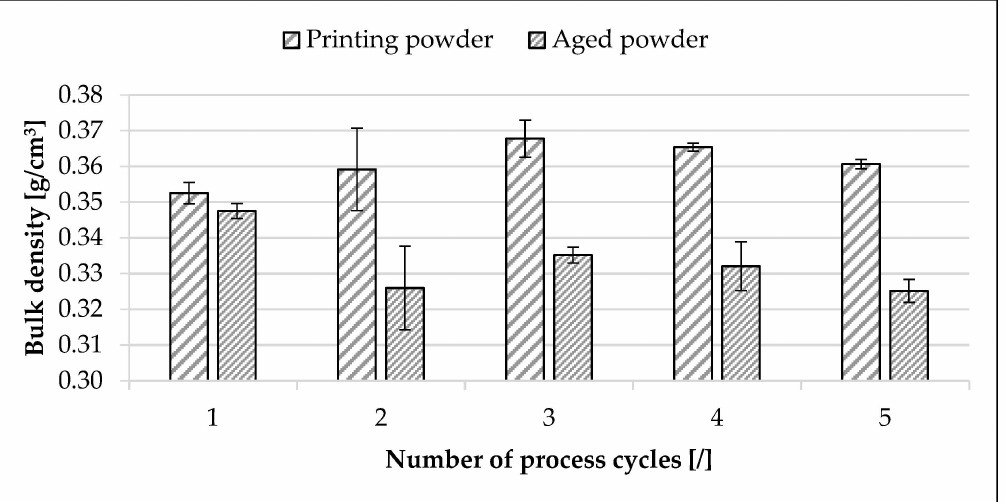
Figure 7. Influence of cyclic reuse on the bulk density of the used polyamide 12 sinter material. Five process cycles were considered. The printing powder and the aged powder were analyzed. The refresh rate was 30 wt%.